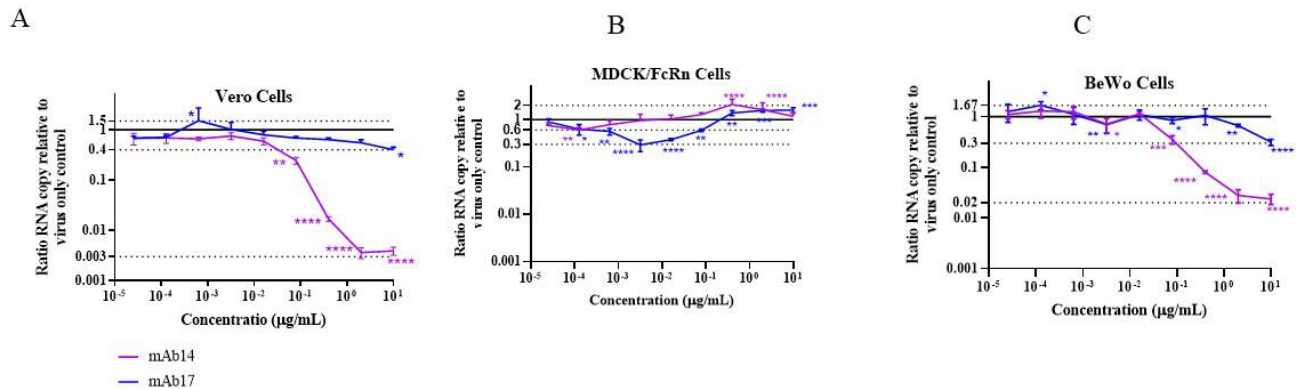
Figure 5. Neutralization of ZIKV infection by anti-ZIKV monoclonal antibody mAb14 (magenta) and anti-flavivirus antibody mAb17 (blue) in ( A ) Vero, ( B ) MDCK/FcRn and ( C ) BeWo cell lines. Neutralization experiments in three cell lines were repeated at least two times, representative graphs are shown. Each data point represents the average of quadruplicates. Data was analyzed with two-way ANOVA test, comparing infection at each antibody concentration to the no-antibody controls; * p < 0.05, ** p < 0.01, *** p < 0.0005, **** p < 0.0001.